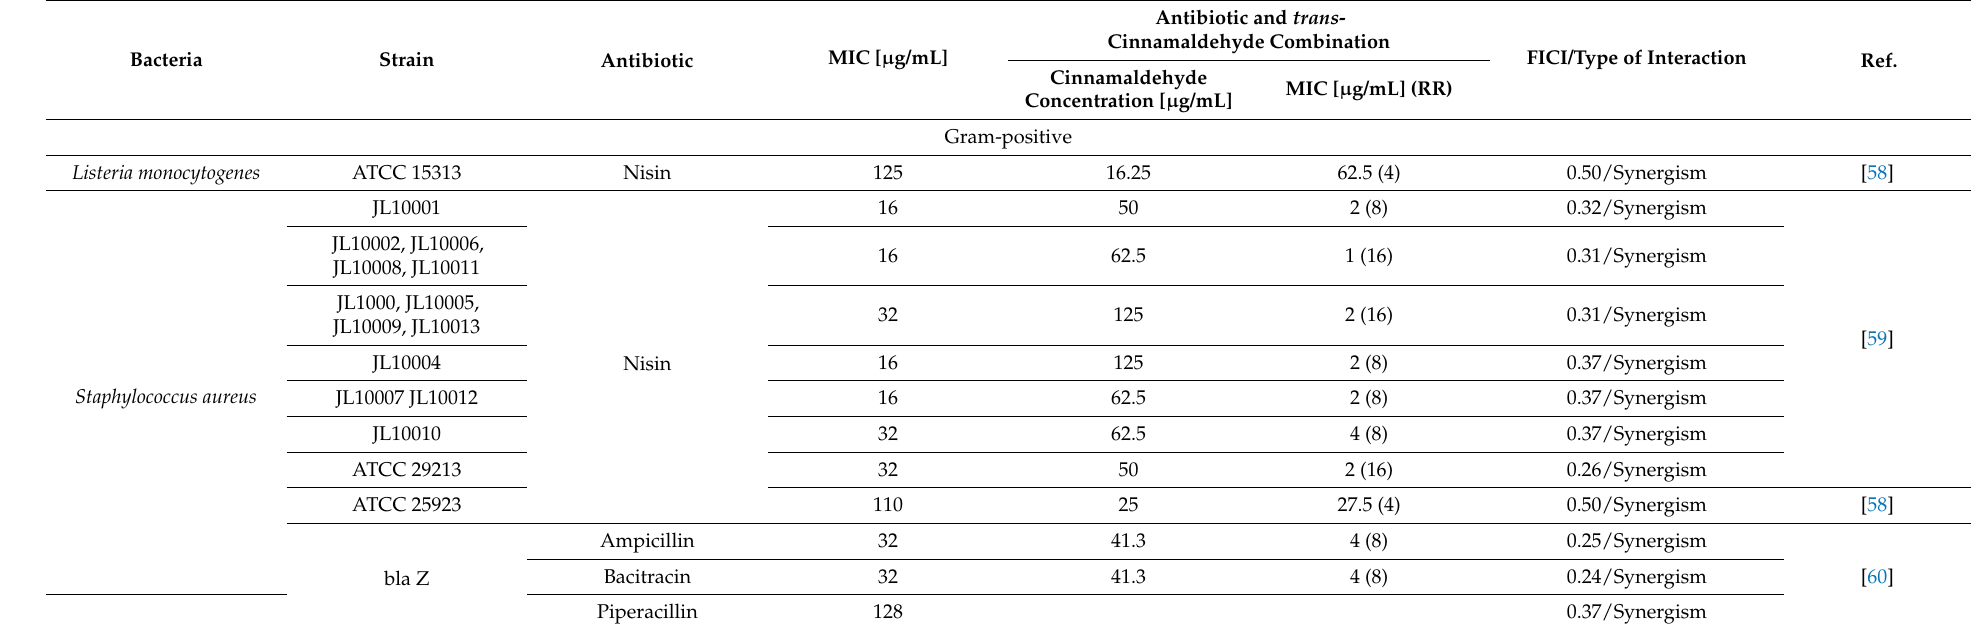
Table 2. Effect of cinnamaldehyde in combination with antimicrobial drugs in bacterial